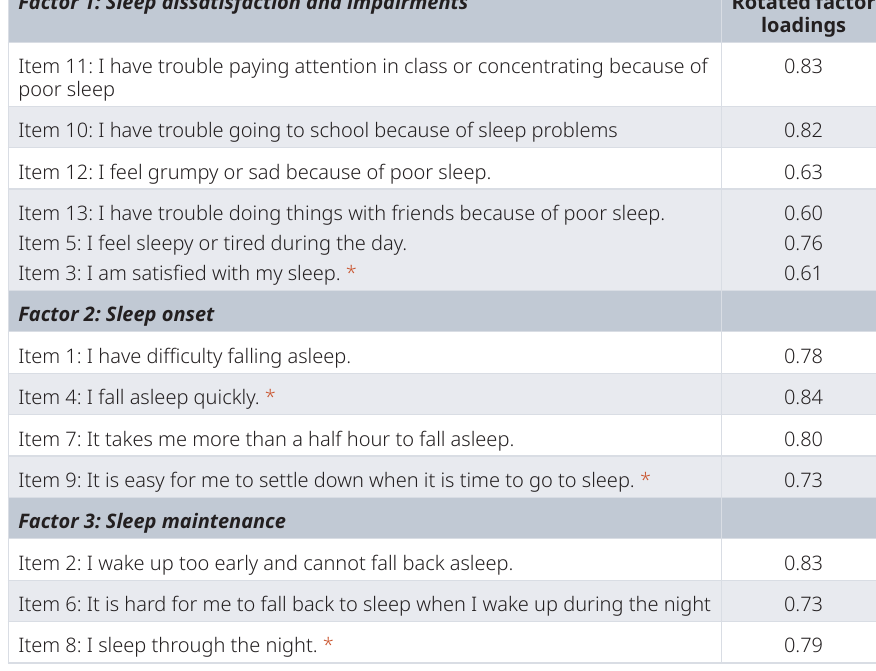
Table 6. Factor loadings in the three-factor model (13 items). Factor 1: Sleep dissatisfaction and